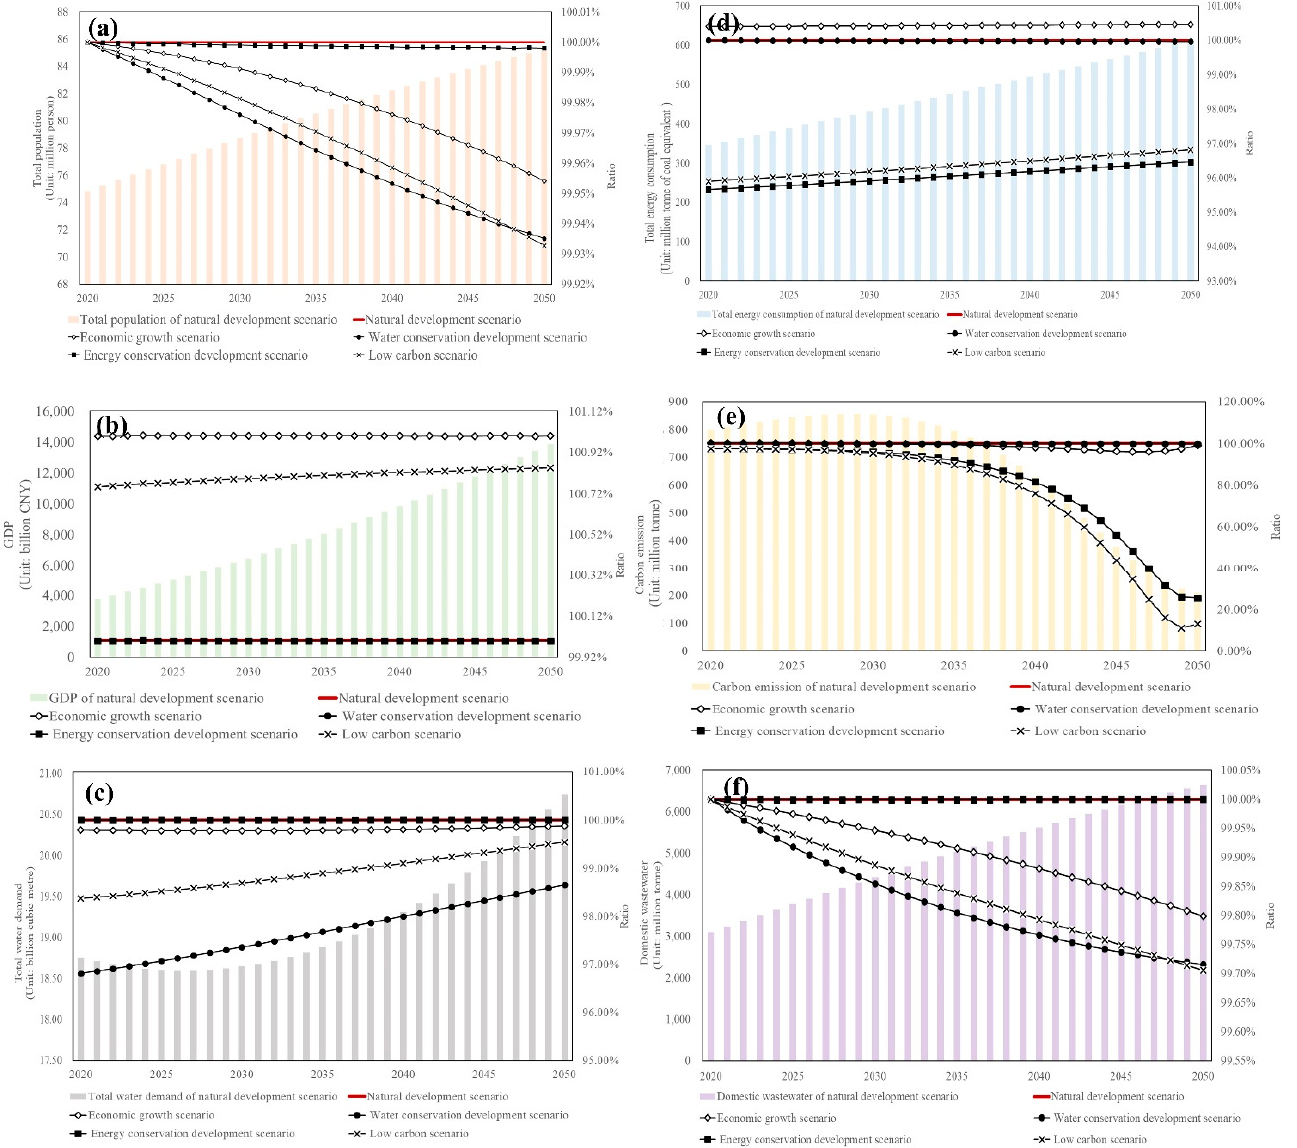
Figure 4. Metabolic trends of social and economic variables of natural development scenario for Hebei metabolic system and the ratios of that of other different scenarios to natural development scenario from 2020–2050 (( a ). Total population; ( b ). GDP; ( c ). Total water demand; ( d ). Total energy consumption; ( e ). Carbon emission; ( f ). Domestic wastewater).